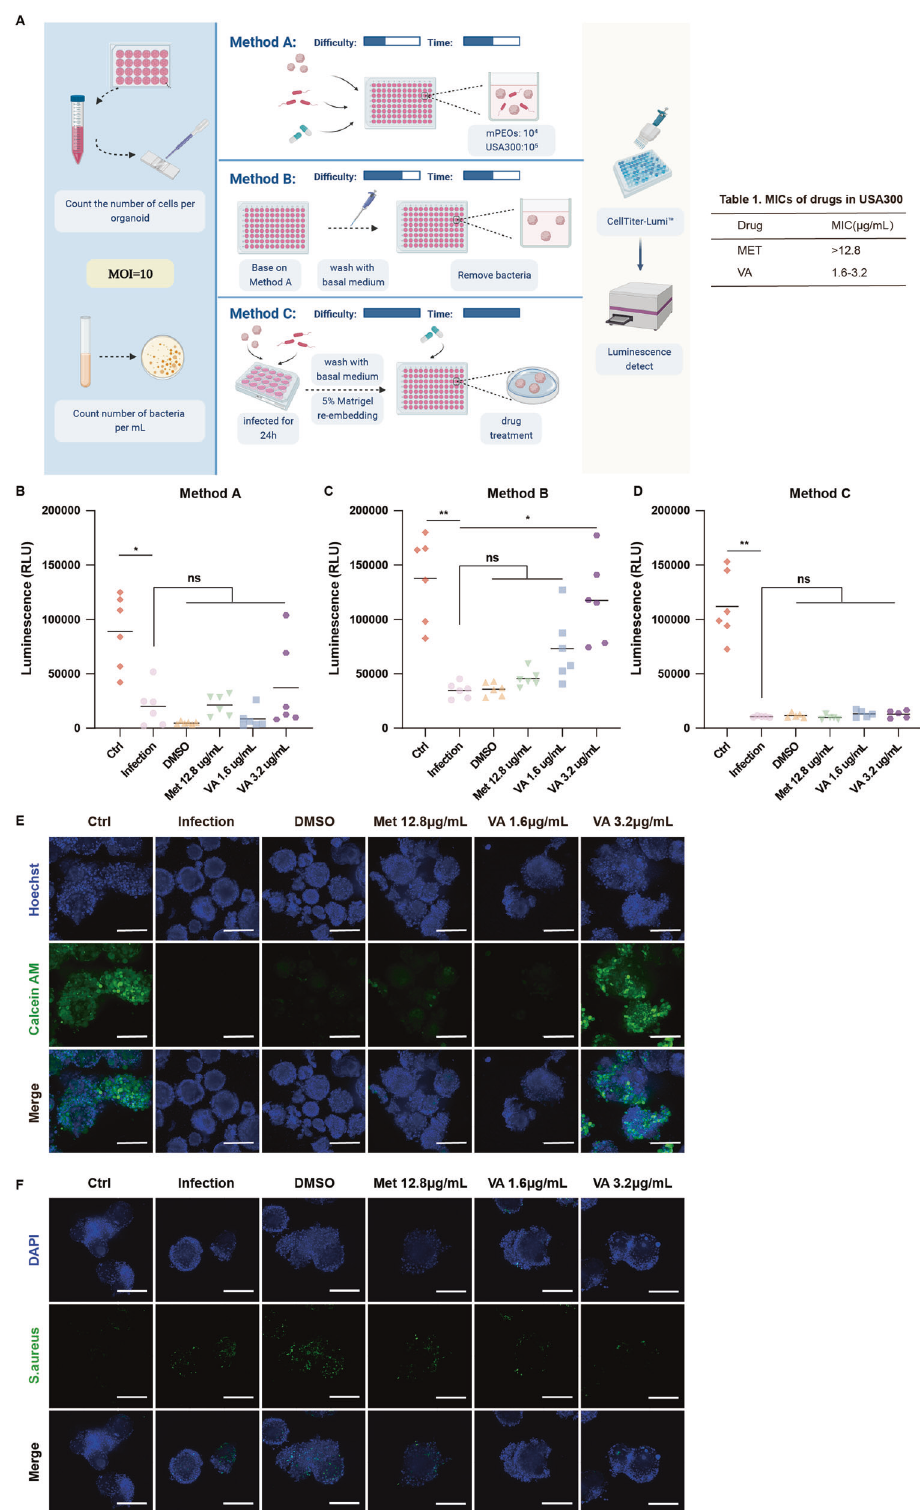
We selected clinically used antibiotics methicillin and vancomycin for drug testing. We measured the